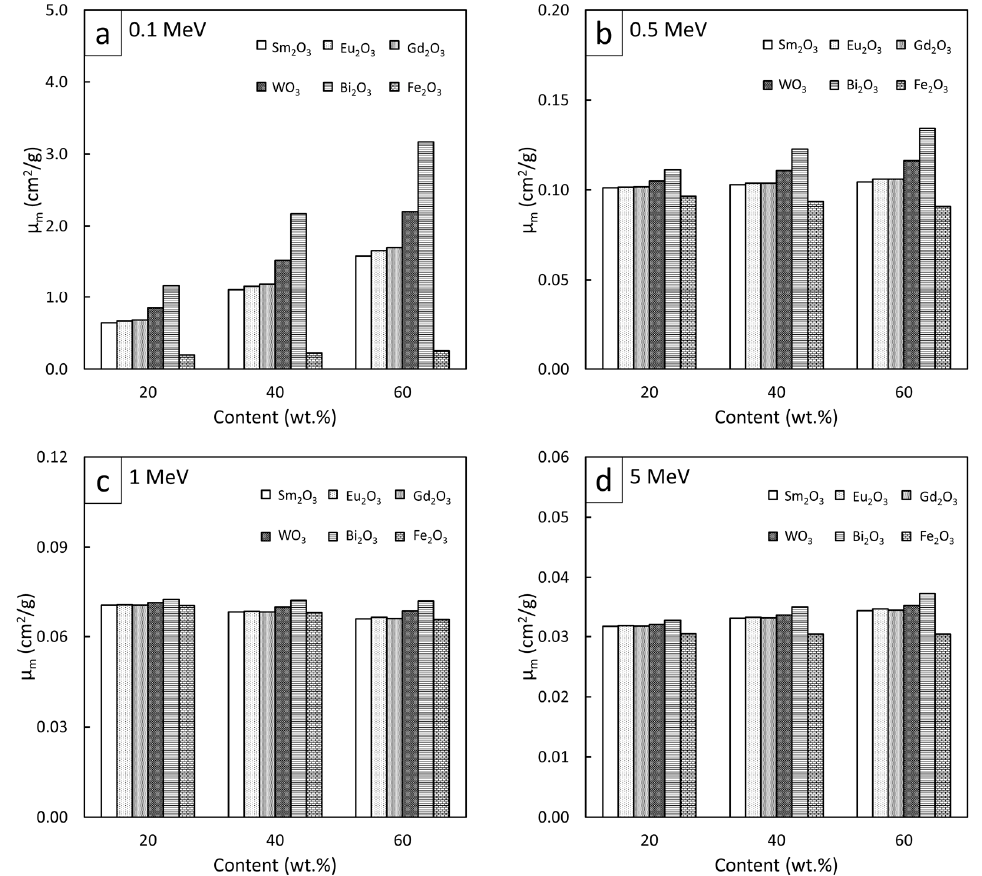
Figure 7. Comparative µ m values of Sm 2 O 3 /HDPE, Eu 2 O 3 /HDPE, and Gd 2 O 3 /HDPE composites with other common Pb-free HDPE composites (Bi 2 O 3 /HDPE, WO 3 /HDPE, and Fe 2 O 3 /HDPE) at filler contents of 20, 40, and 60 wt.% and photon energies of ( a ) 0.1 MeV, ( b ) 0.5 MeV, ( c ) 1 MeV, and ( d ) 5 MeV.